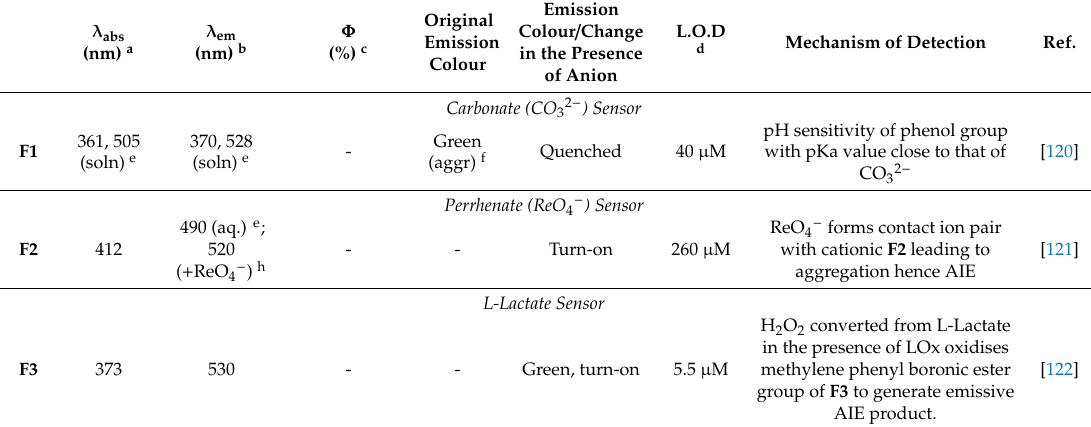
Table 9. Optical properties and sensing performances of AIE-based chemosensors for the sensing of carbonate, perrhenate, lactate, citrate and anionic surfactants ( F1 – F9 ).